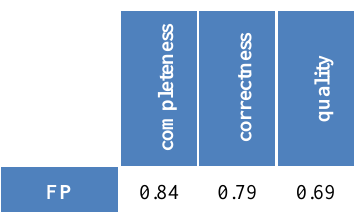
Table 4: completeness, correctness and quality assessment of full parameters case for the subset area of the year